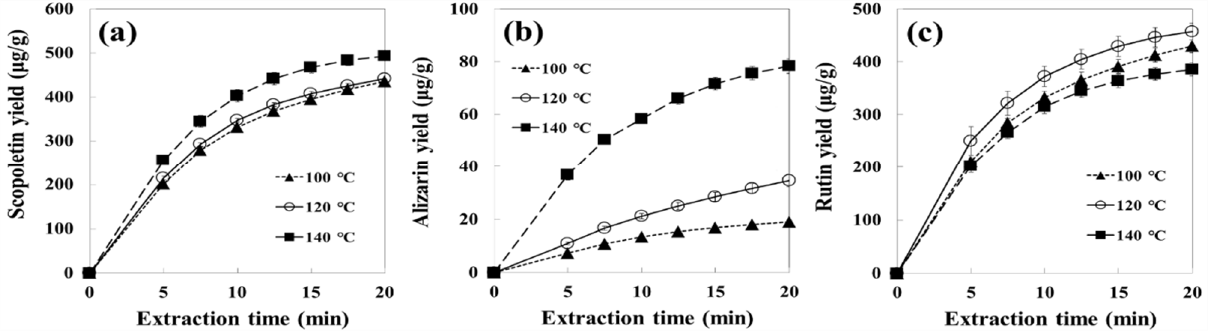
Figure 2. Effect of three different water temperatures on cumulative yields of ( a ) scopoletin, ( b ) alizarin, and ( c ) rutin under a water flow rate of 2 mL/min from noni fruits extracted by subcritical water . Data are mean values ± SD ( n = 3).